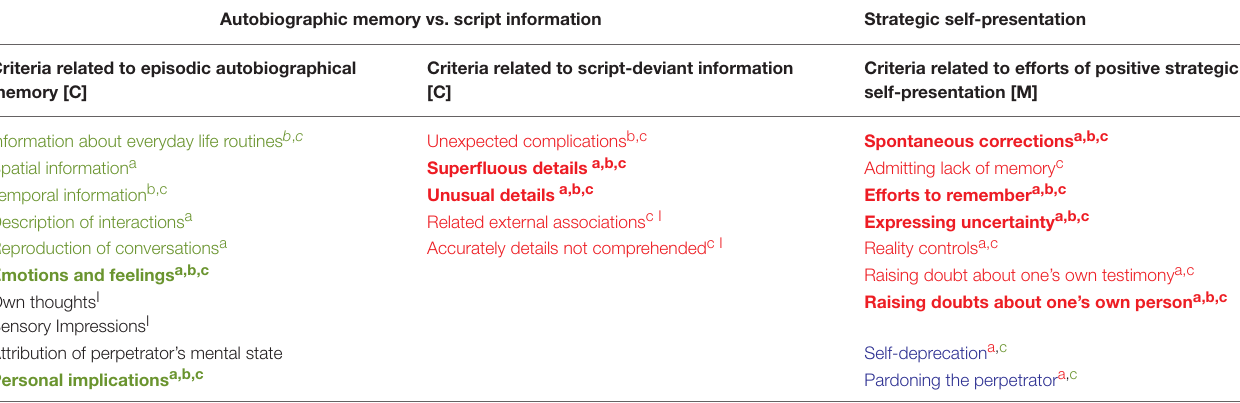
TABLE 5 | Strategic value ratings as obtained from all three studies d . Autobiographic memory vs. script information Strategic